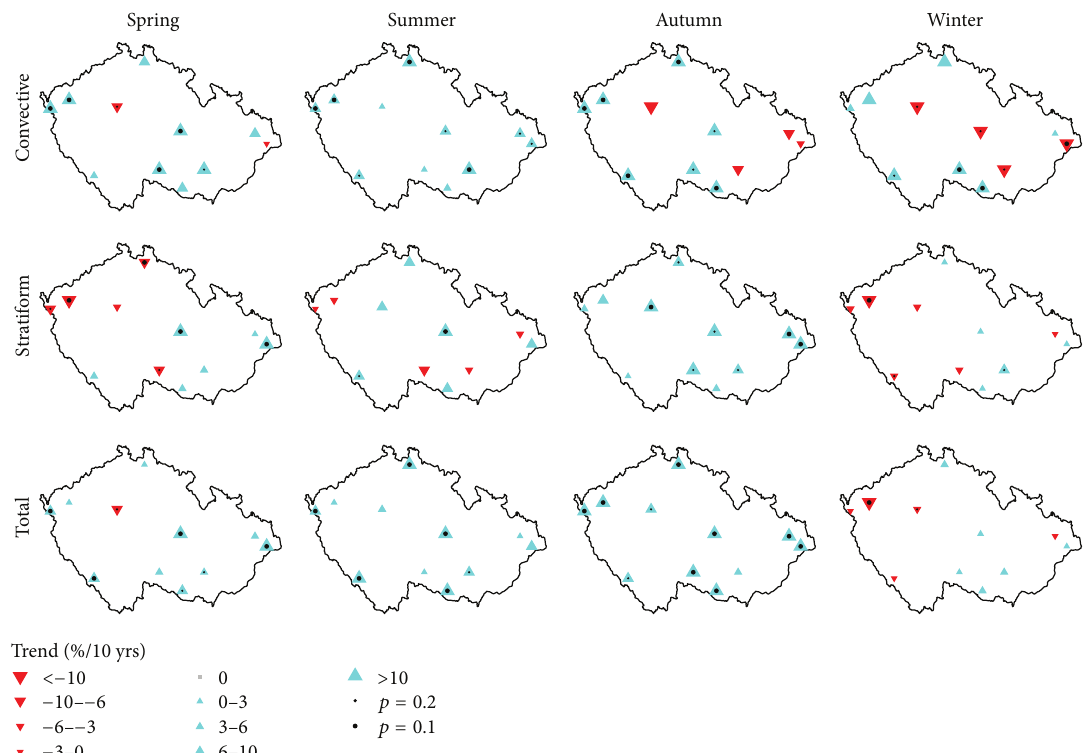
Figure 4: Trends in seasonal amounts of convective, stratiform, and total precipitation computed by the linear regression. Trend magnitudes are expressed as relative changes of the examined characteristics in %/10 years over